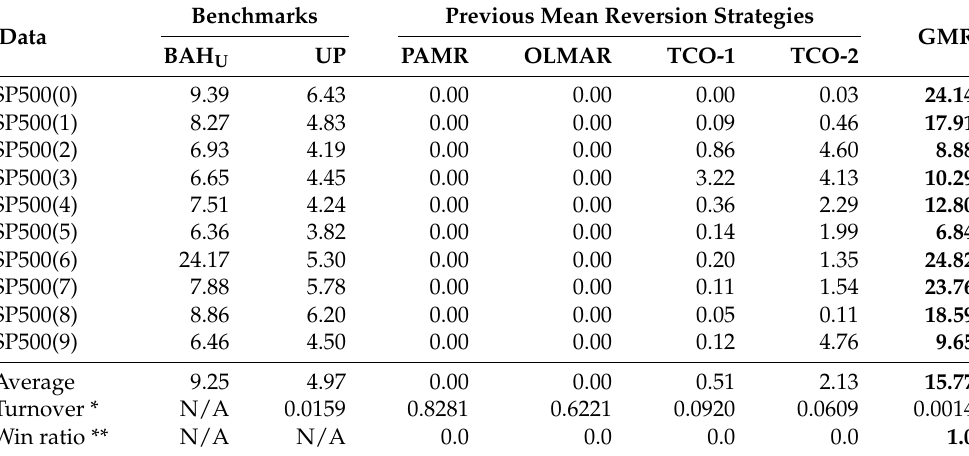
Table 6. Cumulative wealth achieved by various strategies on the S&P 500 datasets. The transaction cost rate was 0.5%. The best values are shown in